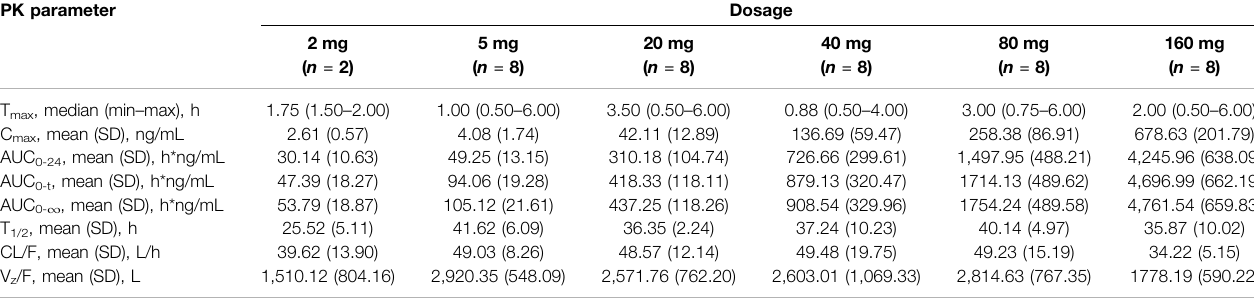
TABLE 3 | Pharmacokinetic (PK) properties of TQ-F3083 after administration of a single ascending dose of 2, 5, 20, 40, 80, and 160 mg. PK parameter